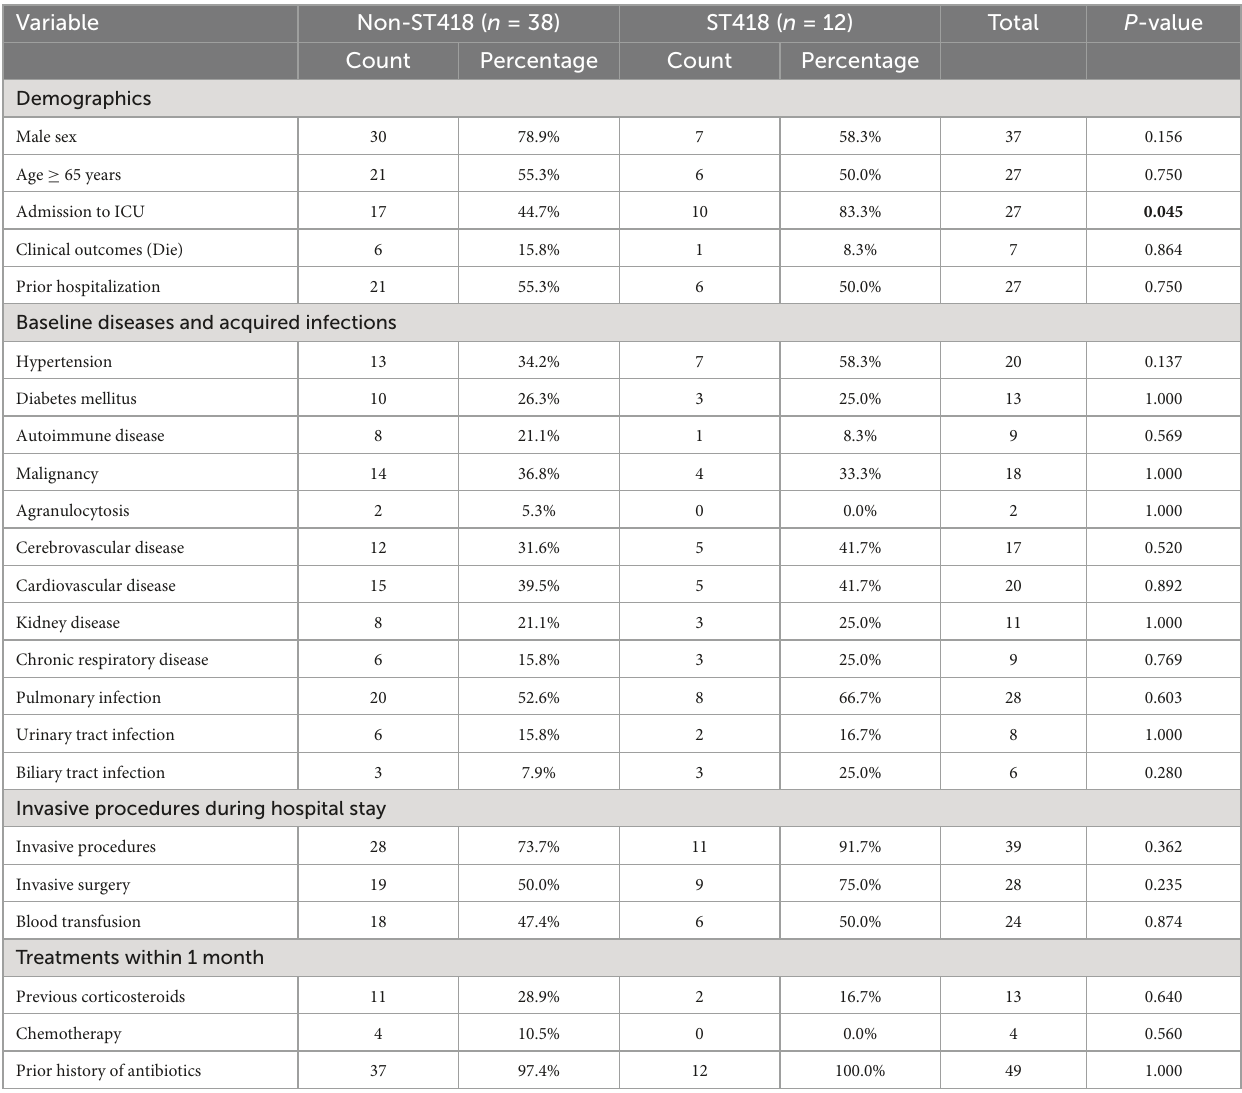
TABLE 4 Univariate analysis of risk factors for infection with ST418 and non-ST418 strains. Variable Non-ST418 ( n = 38) ST418 ( n =